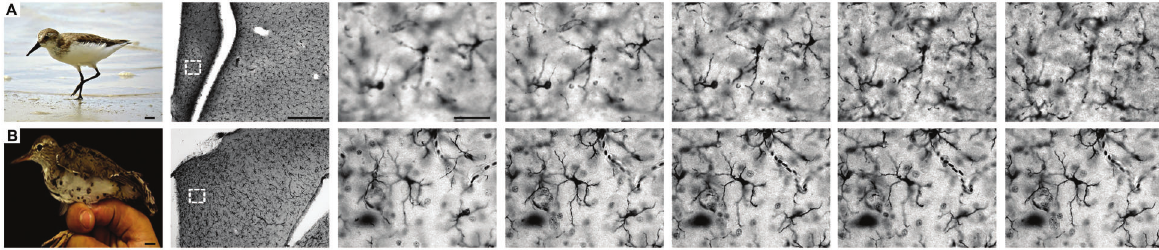
Figure 4. Microscopic appearance of sandpiper microglia. Photomicrographic series at different planes of focus to show microglial immunolabeling in selected sections from the hippocampal formation of Calidris pusilla and Actitis macularia . The dotted square region at low magni fi cation shows the relative position of microglia illustrated at higher magni fi cation. Scale bars A =6 mm; B =8 mm; low power=250 m m, high power=25 m